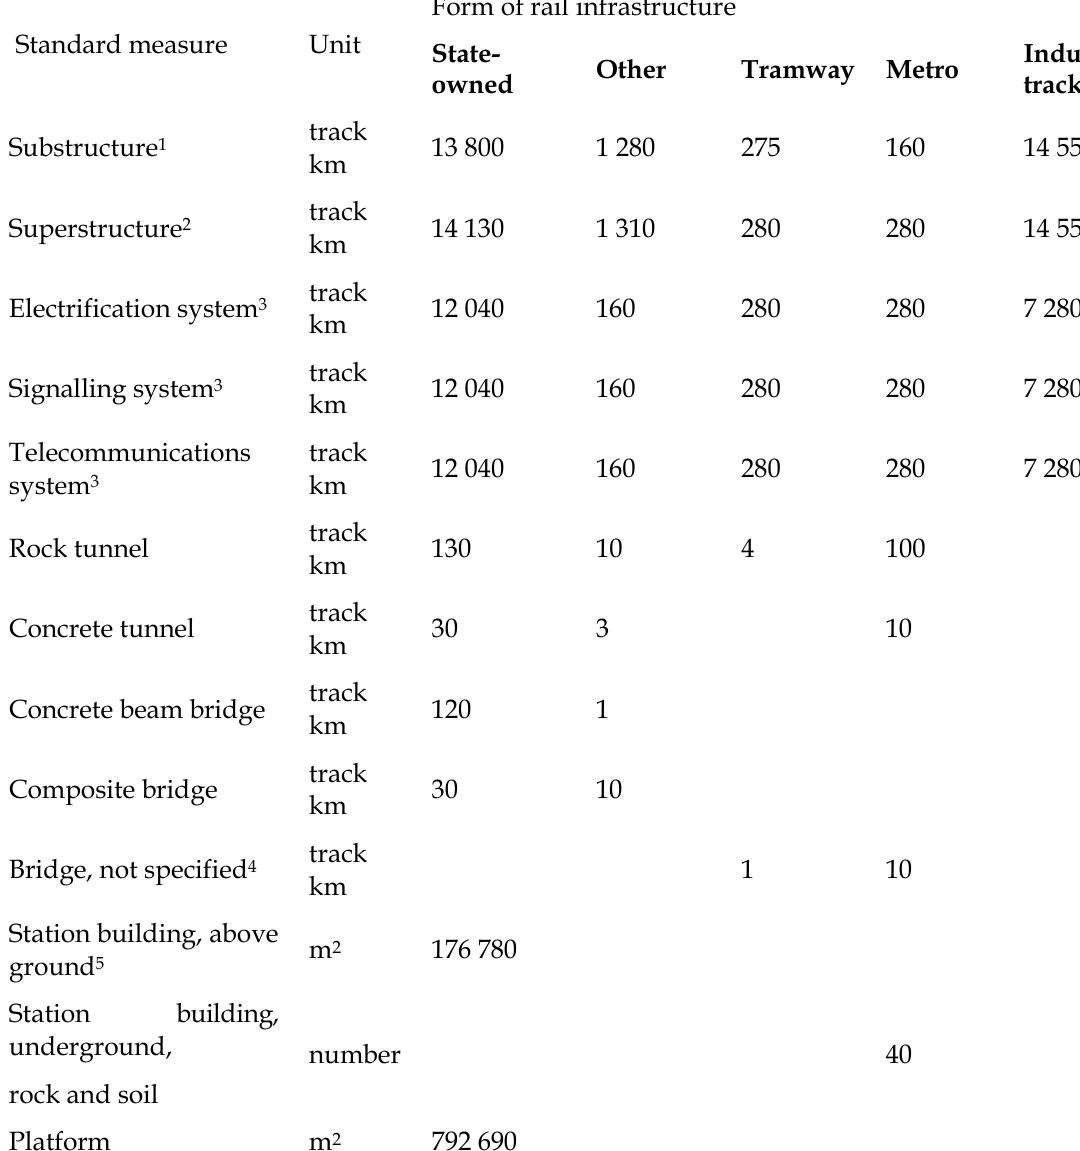
Table A7. Reinvestment of rail infrastructure: the rail infrastructure stock divided into standard measures representing the standard measures in Klimatkalkyl 4.0. Form of rail